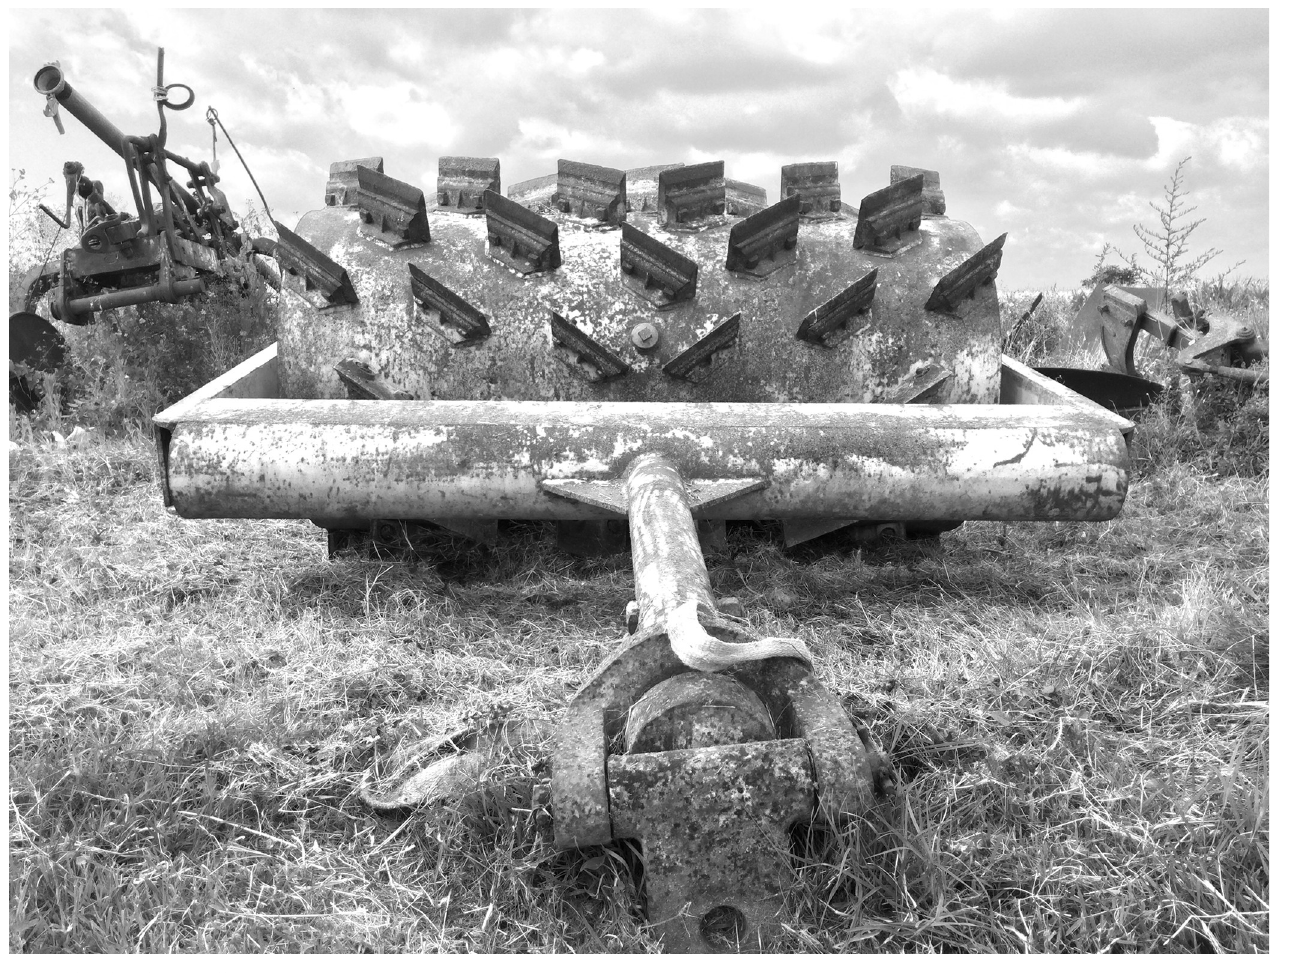
Fig 3. The Fleco heavy